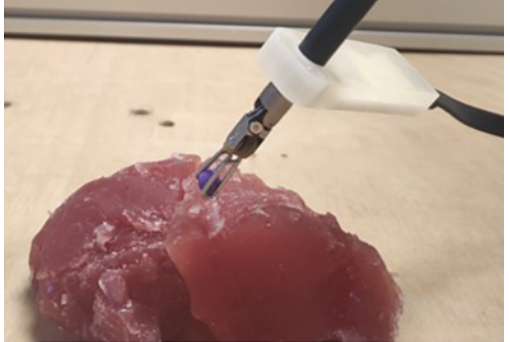
Figure 13. Positioning of the ball on the object placed on the work